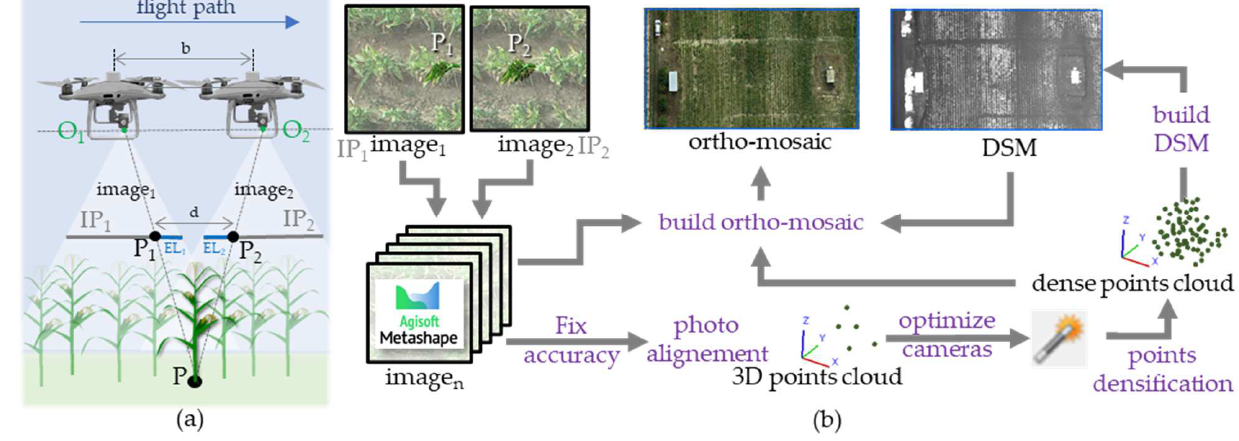
Figure 19. Image acquisition and photogrammetric processing. ( a ) Shooting of a couple of stereo images of a maize plant P, with, IP 1 and IP 2 the image plane of image 1 and 2 respectively, P 1 and P 2 the projections of point P in the two image planes, b the base and d the disparity; ( b ) photogrammetric processing workflow with Agisoft Metashape software.